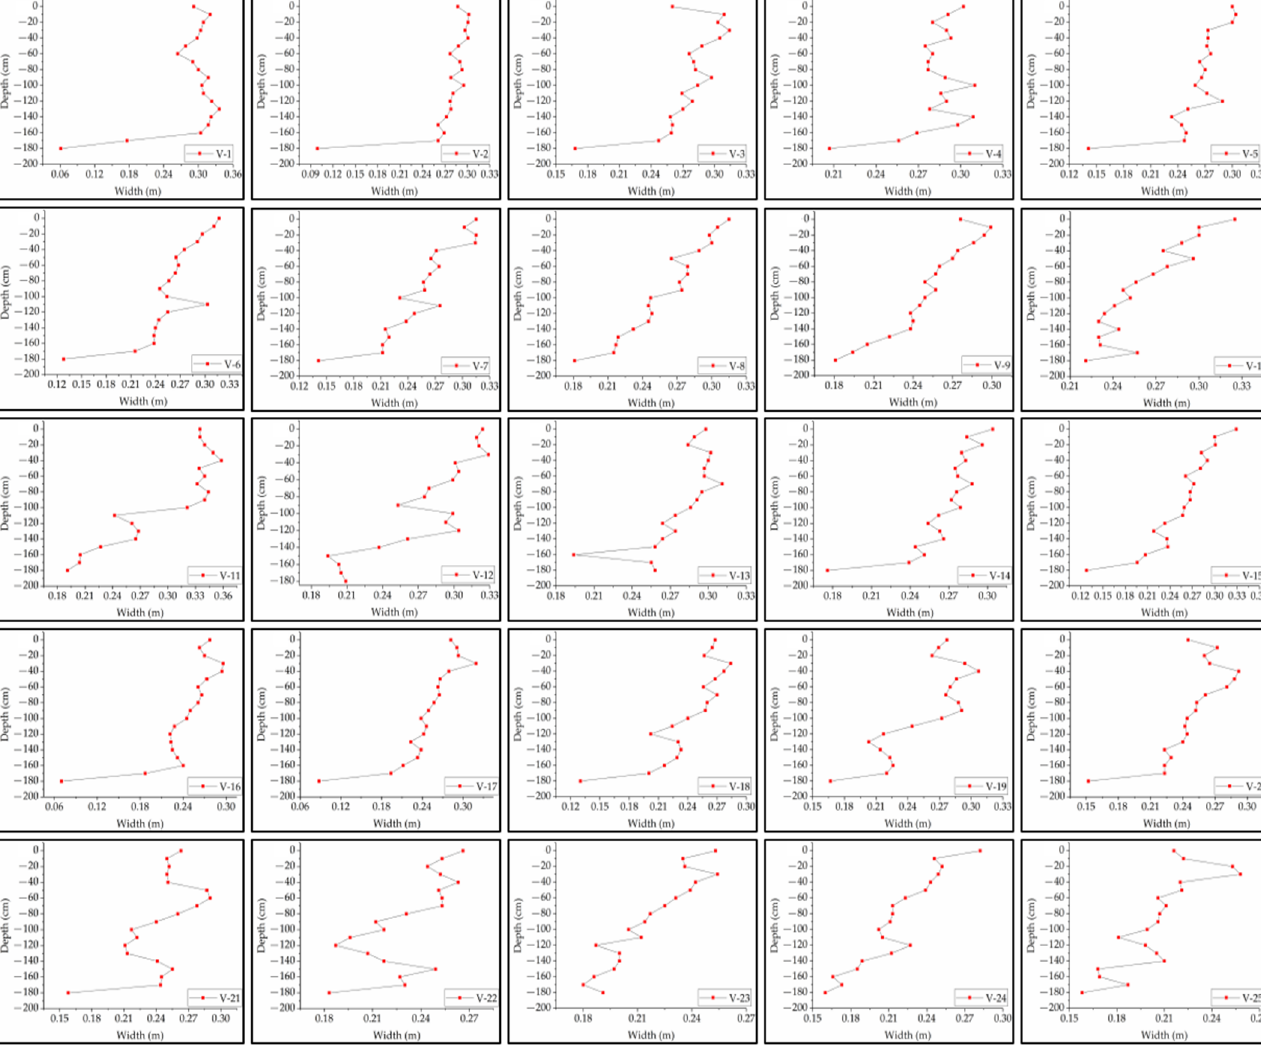
Figure 13. The variation of the width with